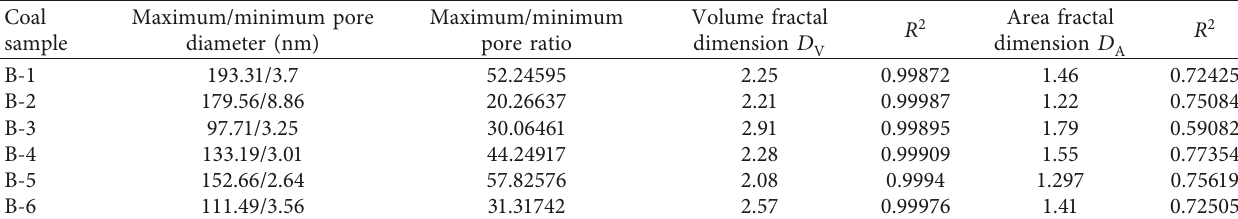
Figure 9: Fractal dimension of pore structure in different coal seams. Table 4: Maximum and minimum pore radius and volume/area fractal dimension for the B-1 to B-6 coal